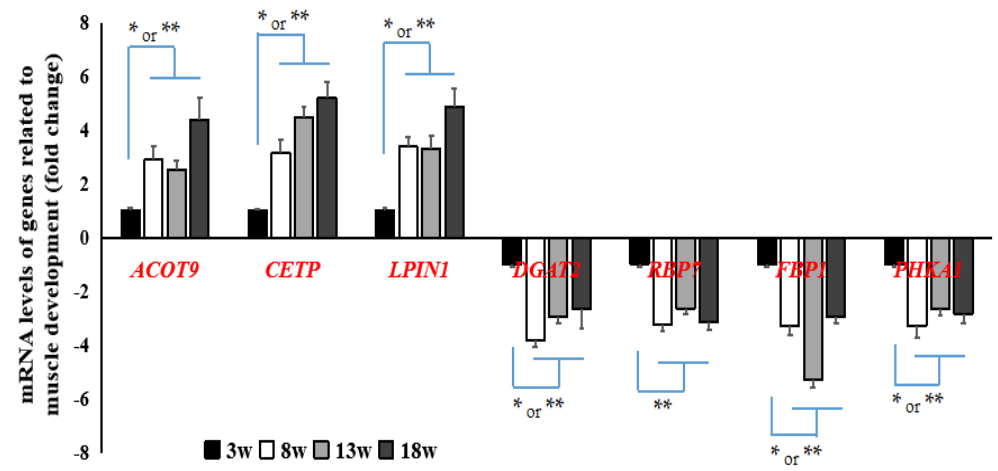
Figure 6. Verification of DEGs related to energy metabolism by quantitative real-time polymerase chain reaction (qRT-PCR). These DEGs were significantly upregulated or downregulated or (* p < 0.05 or ** p < 0.01) in breast muscle tissue at 8, 13, and 18 weeks when compared to those at 3 weeks. n = 9.